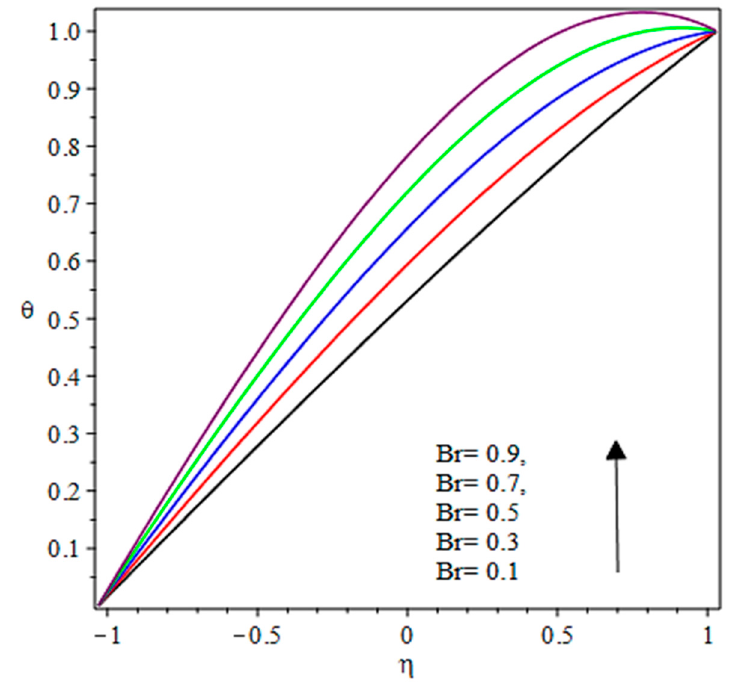
Figure 26. Influence of Br on the temperate distribution at ξ = 0.